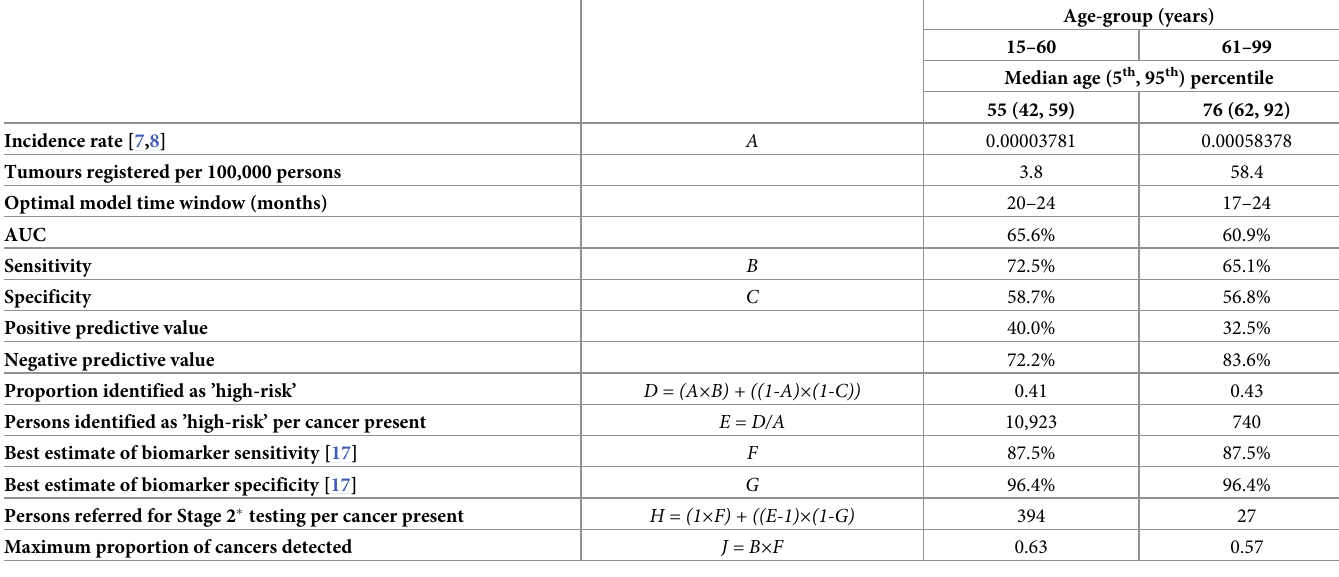
Table 2. Parameters of the optimal logistic regression models envisioned in the context of the hypothetical multi-stage screening model � : England